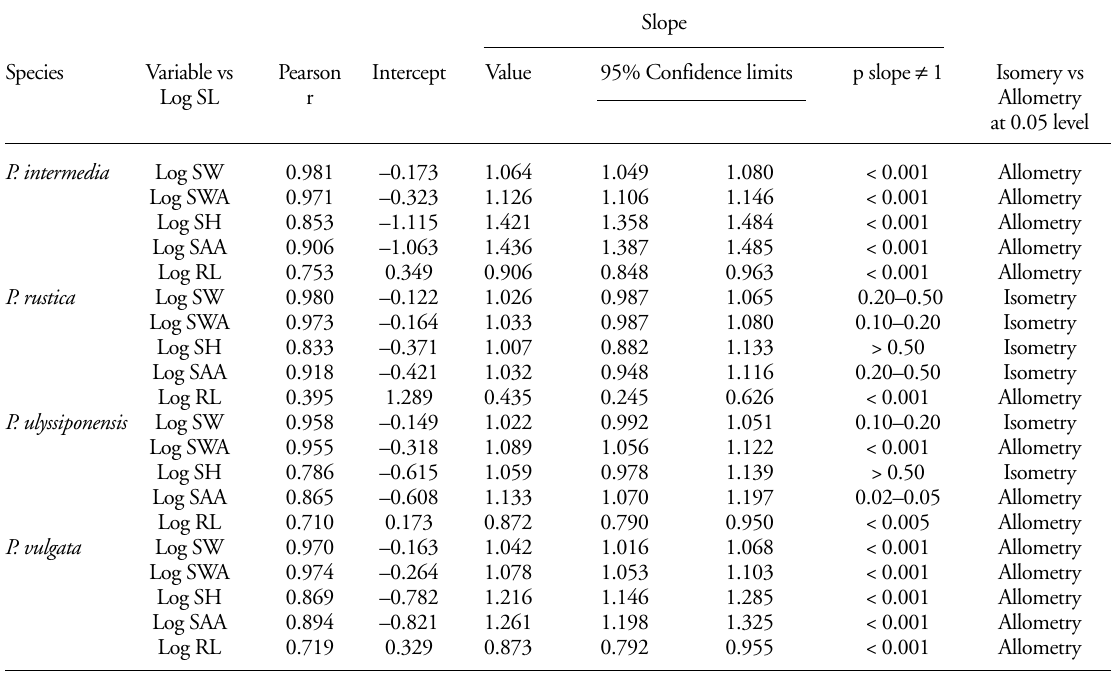
Table 4. Parameters of the regression lines (log transformed) for evaluating shape change during growth and testing isometric vs allometric